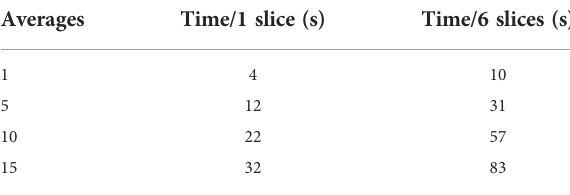
TABLE 2 Time required to collect images with 1 ( fi rst column) or 6 (second column) slices varying the number of averages of the